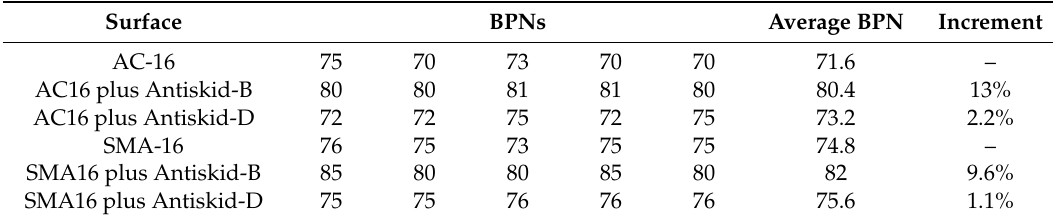
Table 4. British Pendulum Number (BPN) values of the investigated surfaces without